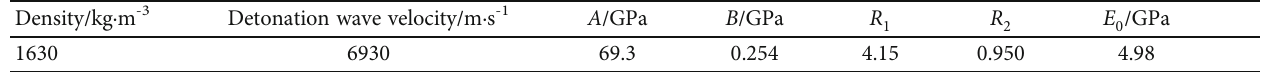
Table 3: Material parameters of the explosive.